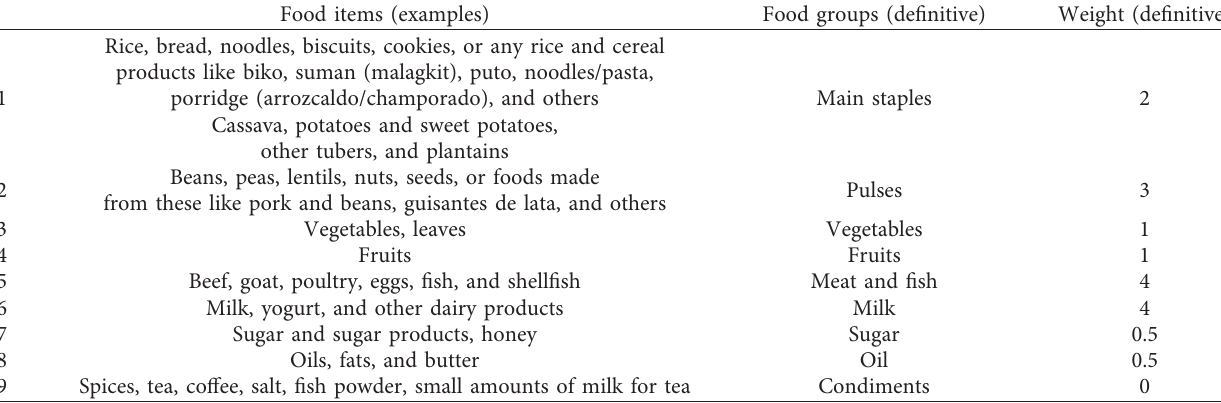
Table 3: FCS of the standard food group and current standard weights by the World Food Programme (WFP) 1 . Food items (examples) Food groups (definitive)